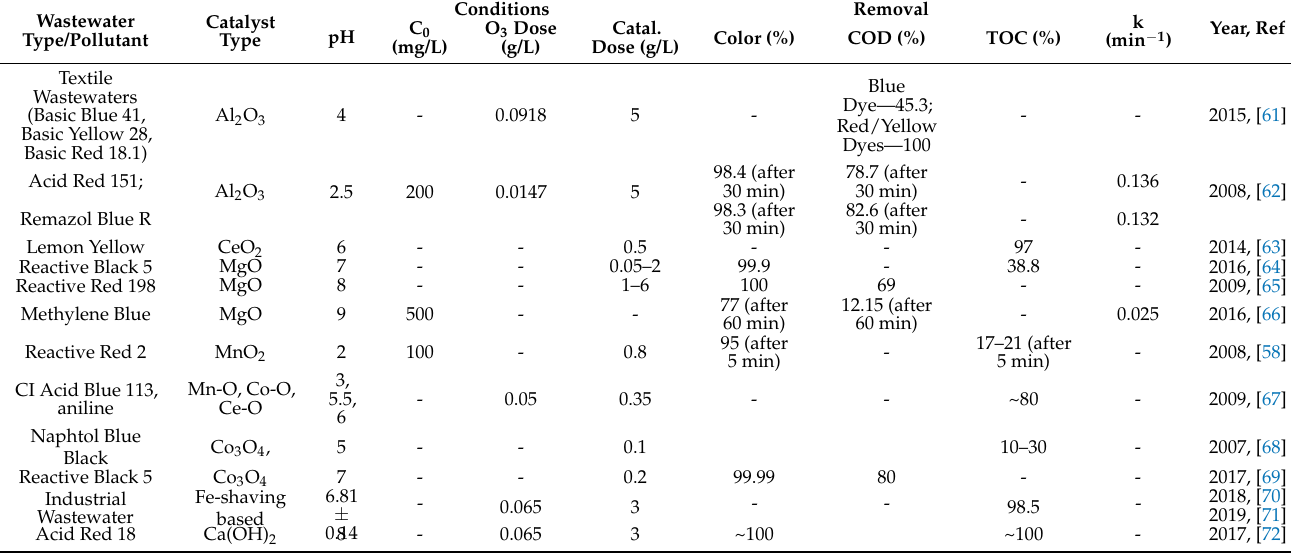
Table 3. Examples of catalytic ozonation with metal